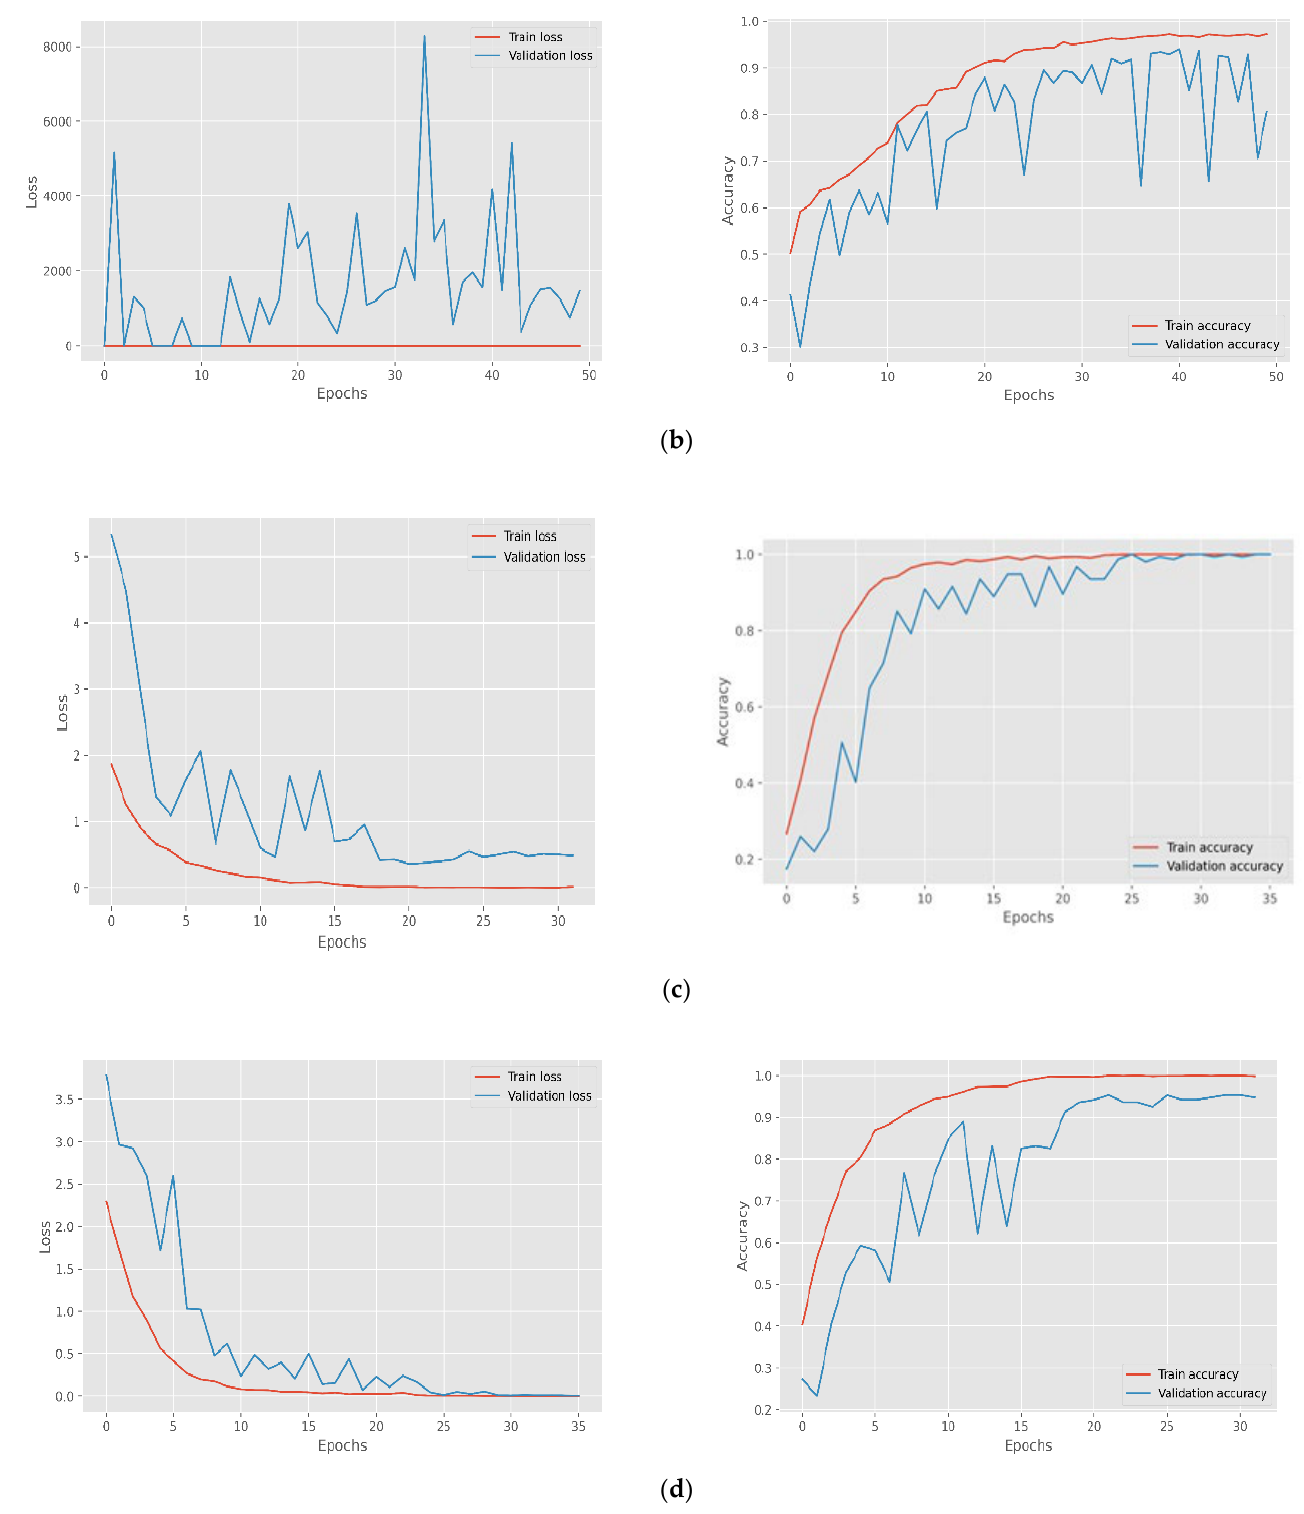
Figure 6. Loss and accuracy plots of the ( a ) ANAD, ( b ) BAVED, ( c ) SAVEE, ( d ) EMO-DB datasets for 1D CNN with the LSTM attention model.